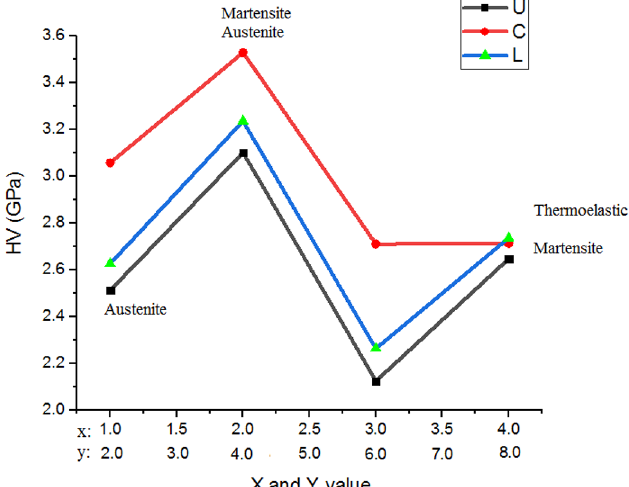
Fig. 4. Vickers micro hardness measured on upper (U), central (C) and lower (L) cross-sections from an alloy Ni 50 – x Fe x Mn 30 Sn 20 – y In y (1 (cid:1) x (cid:1) 4; 2 (cid:1) y (cid:1) 8). Table 2. Compositional analysis of arc melted Ni 50 – x Fe x Mn 30 Sn 20 – y In y (1 (cid:1) x (cid:1) 4; 2 (cid:1) y (cid:1) 8) alloy.